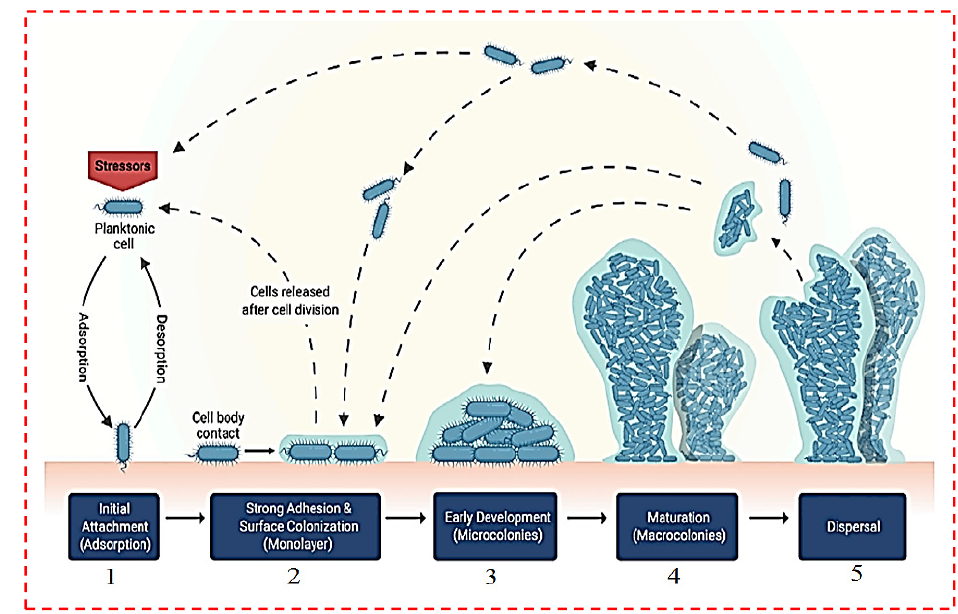
Figure 1. Schematic of the formation of a single bacterial biofilm on a solid surface